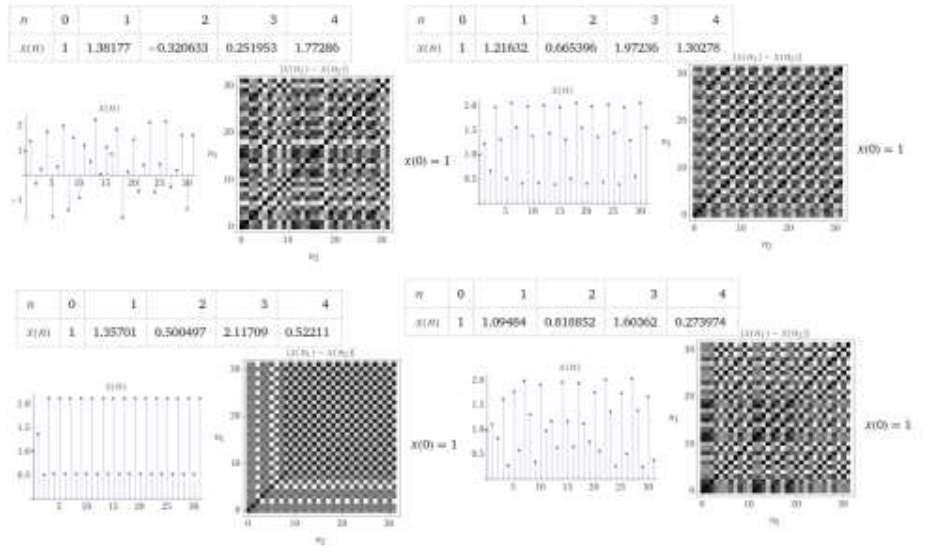
approach to 1. n+1